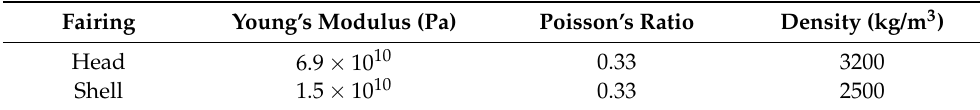
Figure 3. Definitions of the angle of attack and coordinates. Table 1. Material properties of each part of the fairing.